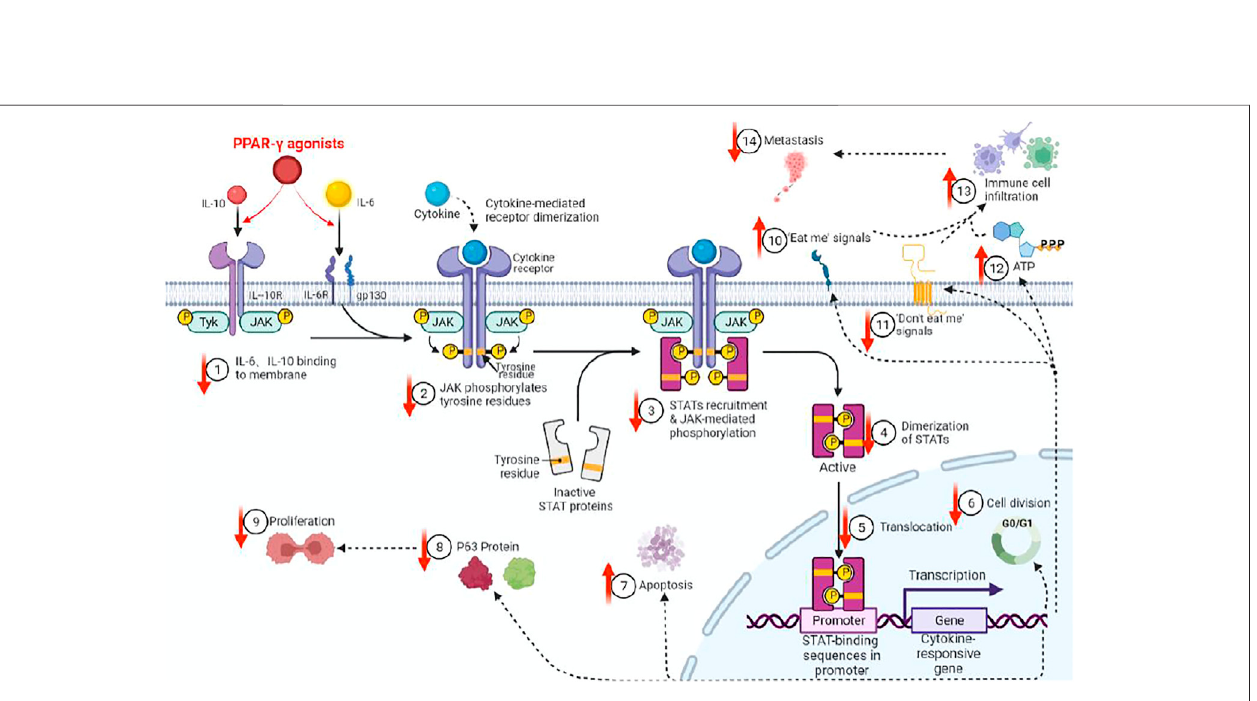
FIGURE 4 | PPAR- γ agonist inhibits JAK-STAT signaling pathway activations through molecules such as IL6/IL10, thereby inhibiting p63 protein expressions in CSCs. We previously showed that PPAR- γ agonists target and inhibit CSC proliferation by downregulating the phosphorylation of the JAK-STATs pathway and p63 protein expressions, etc. ( ↓ =downregulated, ↑